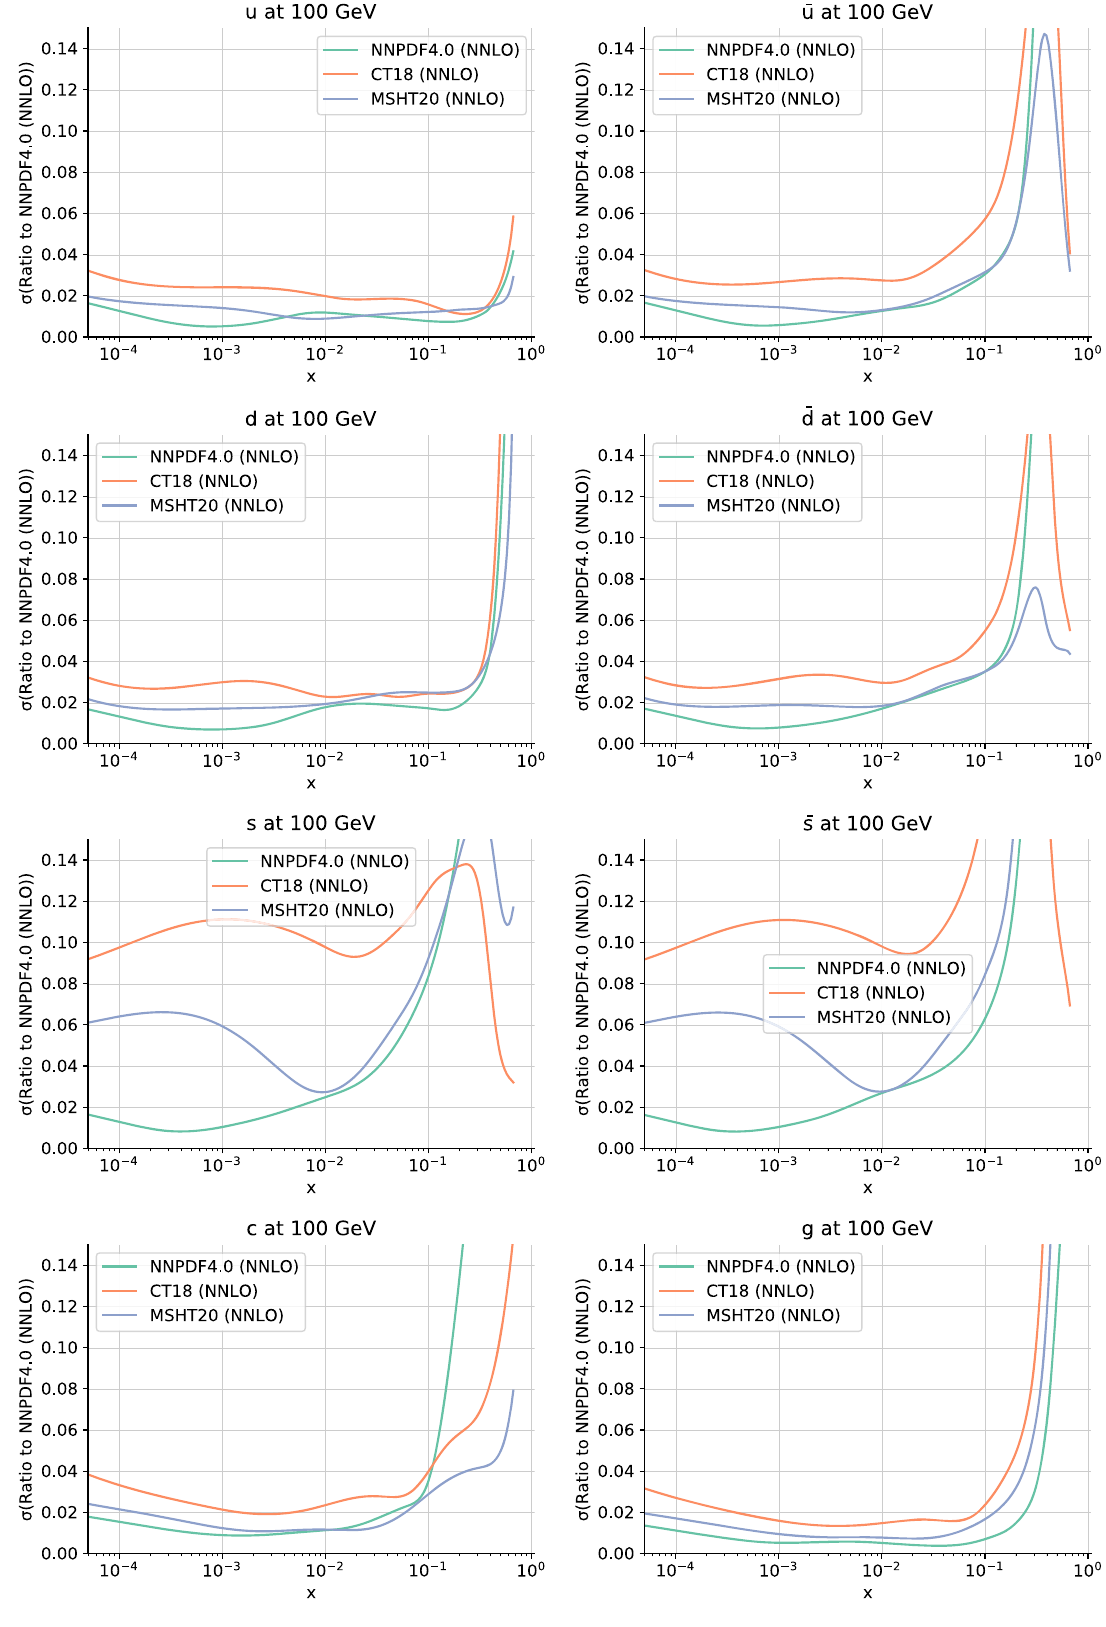
Fig. 22 Same as Fig. 21 but for one-sigma relative